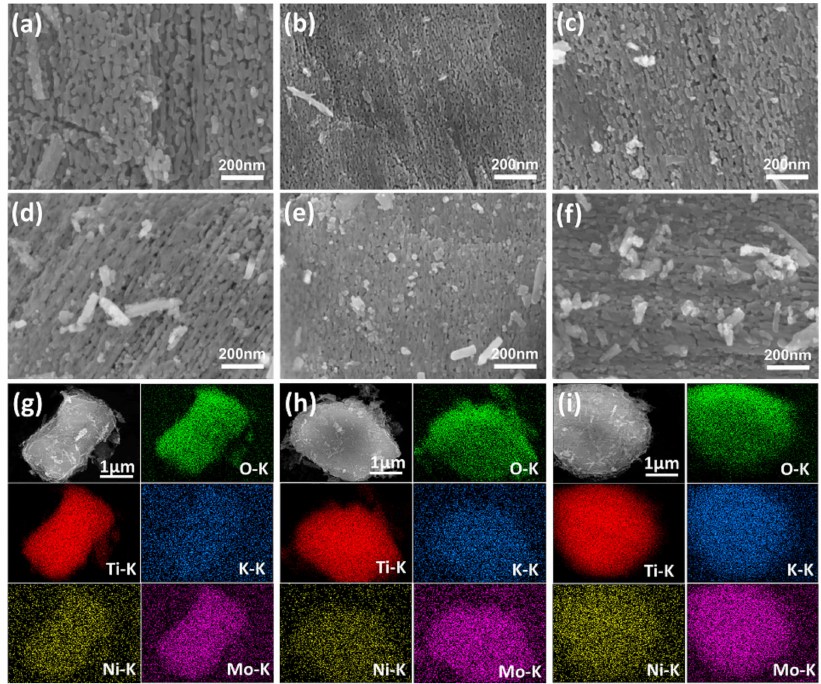
Figure 4. FESEM images of representative catalysts with di ff erent potassium content and their corresponding supports: ( a ) TiO 2 -1, ( b ) TiO 2 -2, ( c ) TiO 2 -6, ( d ) NiMo / TiO 2 -1, ( e ) NiMo / TiO 2 -2, and ( f ) NiMo / TiO 2 -6. EDSmappingimagesofcatalysts: ( g )NiMo / TiO 2 -1, ( h )NiMo / TiO 2 -2and( i )NiMo / TiO 2